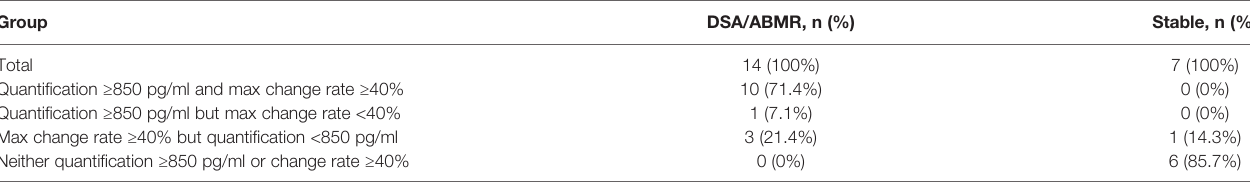
sBAFF, soluble B cell-activating